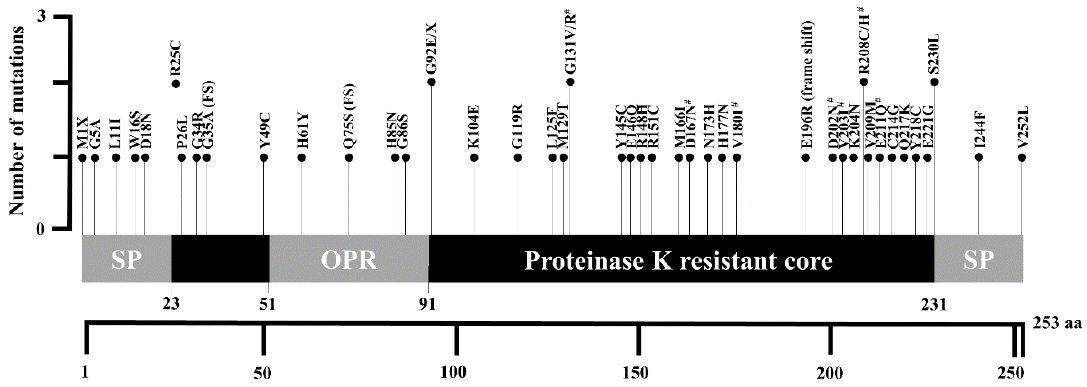
Figure 1. Schematic map of human prion protein (PrP) with somatic mutations of the prion protein gene ( PRNP ) in cancer patients. Sharps indicate previous reported pathogenic mutations of prion diseases. SP: signal peptide; OPR: octapeptide repeat region.